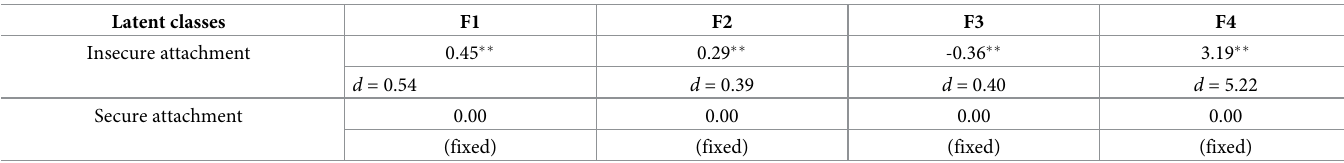
Table 4. Mean factor levels in each class according to the Mixture Factor